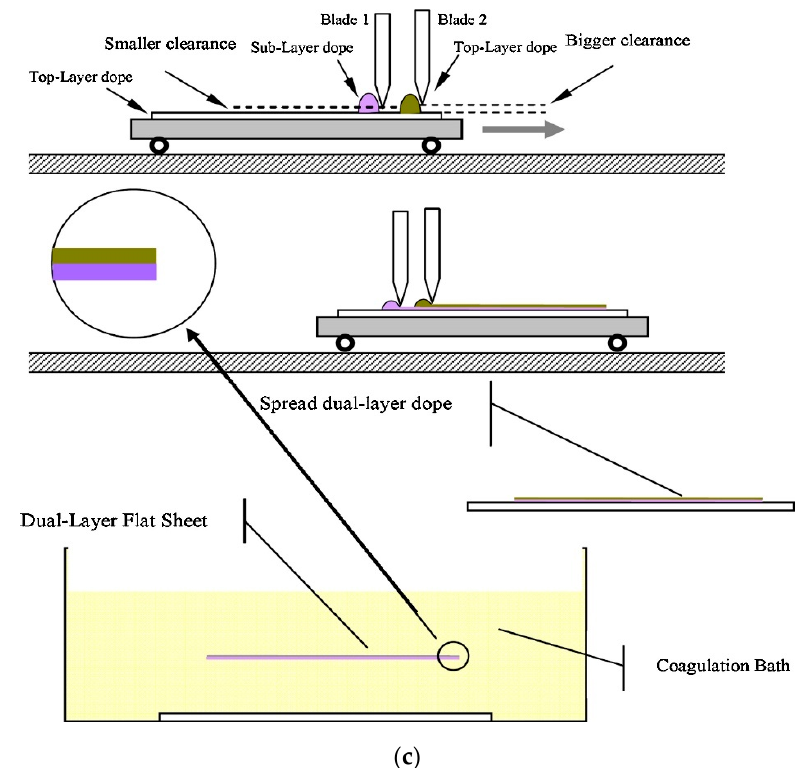
Figure 11. ( a ) Schematic diagram of a dual-layer hollow-fiber spinning process; ( b ) cross section of a triple-orifice spinneret (adapted with permission from [201] ); and ( c ) fabrication process of a dual-layer flat-sheet membrane using a double-blade casting machine (adapted with permission from [202] ).